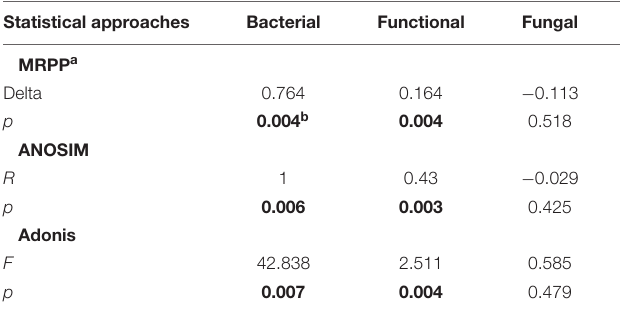
TABLE 1 | Microbial taxonomic and functional gene composition dissimilarities among three Thelephora ganbajun sporocarp compartments (context, hymenophore, and